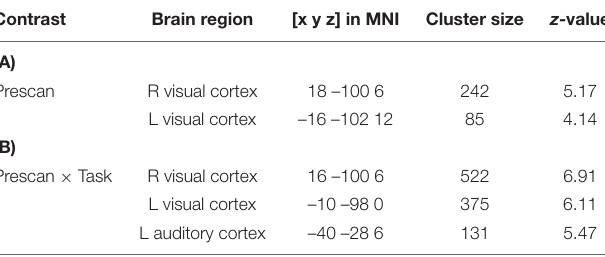
TABLE 2 | Results of the whole-brain ANOVA for (A) the main effect of prescan normalize and (B) the interaction between task and prescan